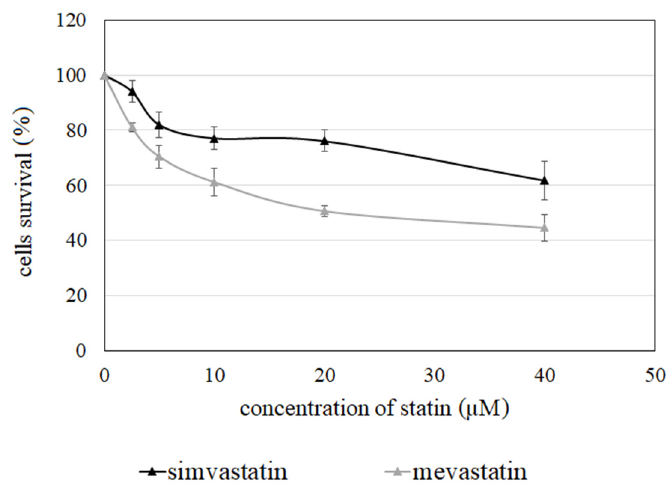
Figure 3. Jurkat T cells survival in the presence of simvastatin and mevastatin. Table 2. IC 50 of flavonoids and flavonoids applied with statins (simvastatin or mevastatin) deter- mined in Jurkat T cells.